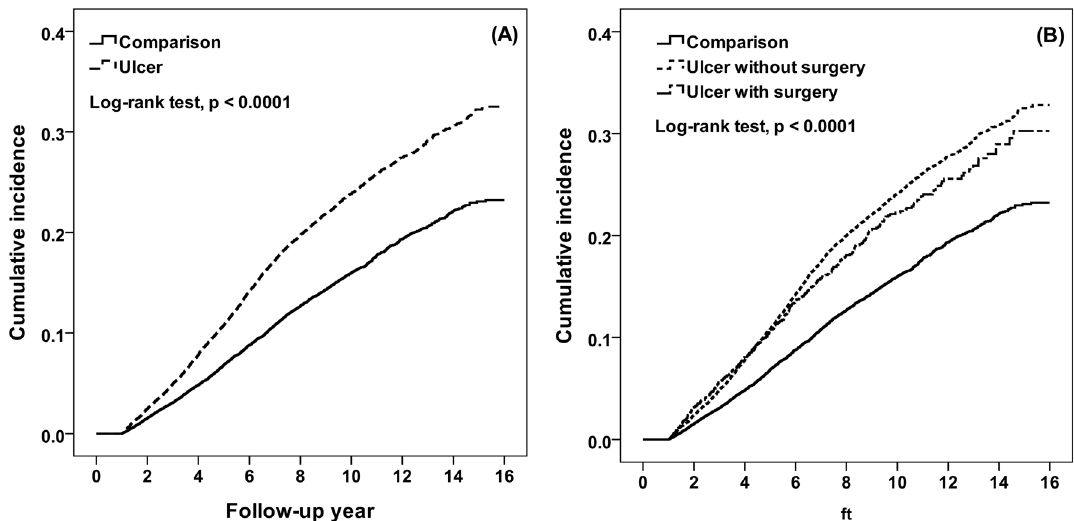
Figure 2. Kaplan–Meier analysis measured cumulative incidence of benign prostatic hyperplasia for comparison cohort and ulcer cohort.